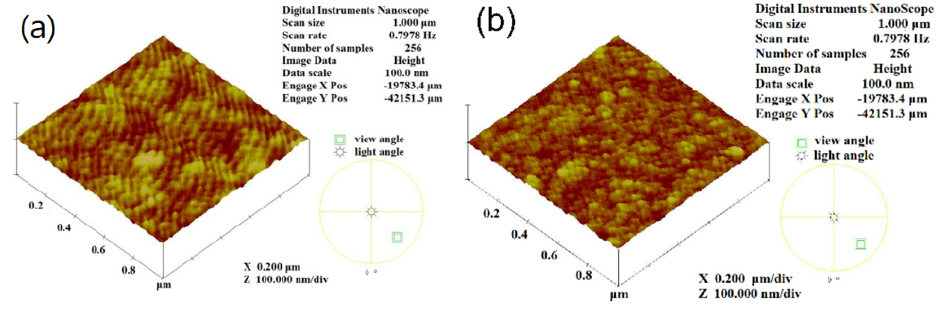
Figure 5. Surface roughness map of the sample measured by AFM ( a ) before coating; ( b ) after coating.